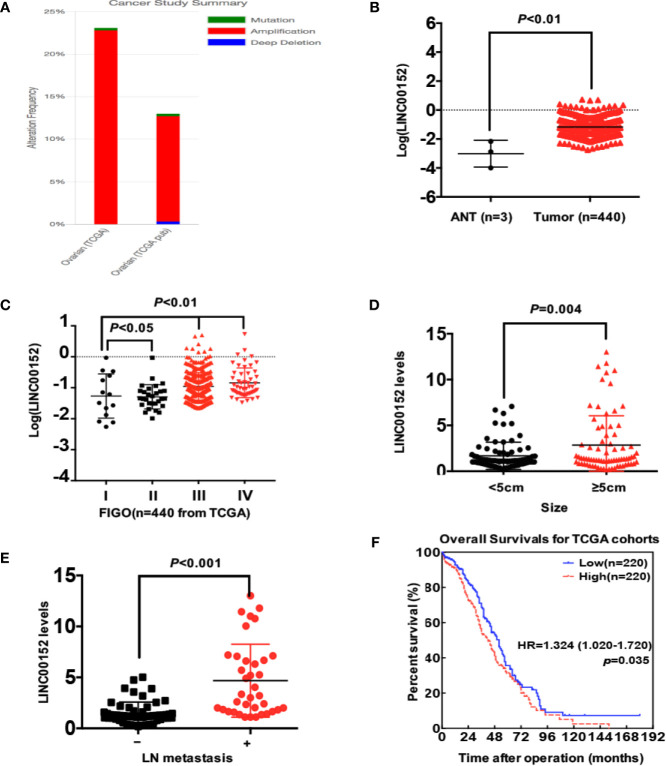
The statistical analysis of LINC00152 expression in TCGA data (www.cbioportal.org). (A) The summary of LINC00152 status in 2 independent cohorts from TCGA analyzed by www.cbioportal.org. The gene status included mutation, amplification and deep deletion. (B) The expression of LINC00152 in ovarian cancer tissues and adjacent normal tissues (ANTs) in cohorts from TCGA (n = 440). P < 0.01. (C) The expression of LINC00152 in the cases at different FIGO stages (n = 440) from TCGA. P < 0.05. (D) The comparison of LINC00152 expression in 152 cases with ovarian cancer divided by tumor sizes (<5 cm and ≥5 cm). P < 0.01. (E) The comparison of LINC00152 expression in 152 cases with ovarian cancer divided by the metastatic status of lymph nodes. P < 0.01. (F) The overall survivals (OS) of cases divided with the expression of LINC00152 in the cohorts from TCGA. P < 0.05.